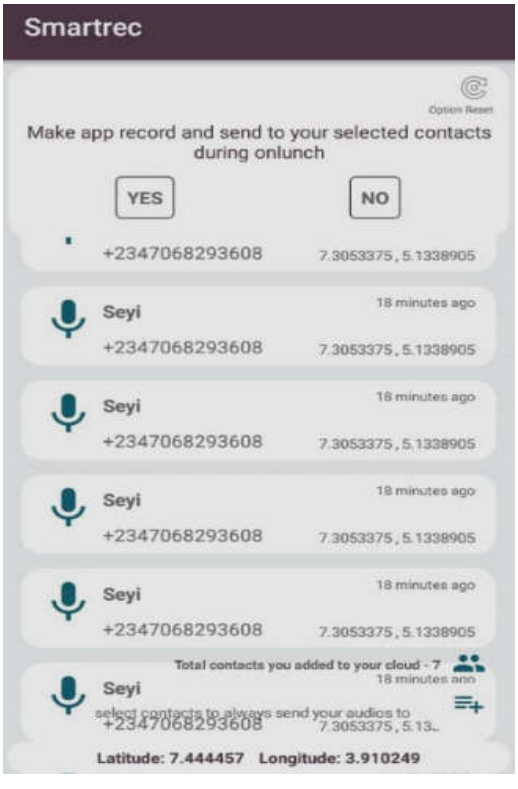
Figure 10 . Recorded Audio File Transmission